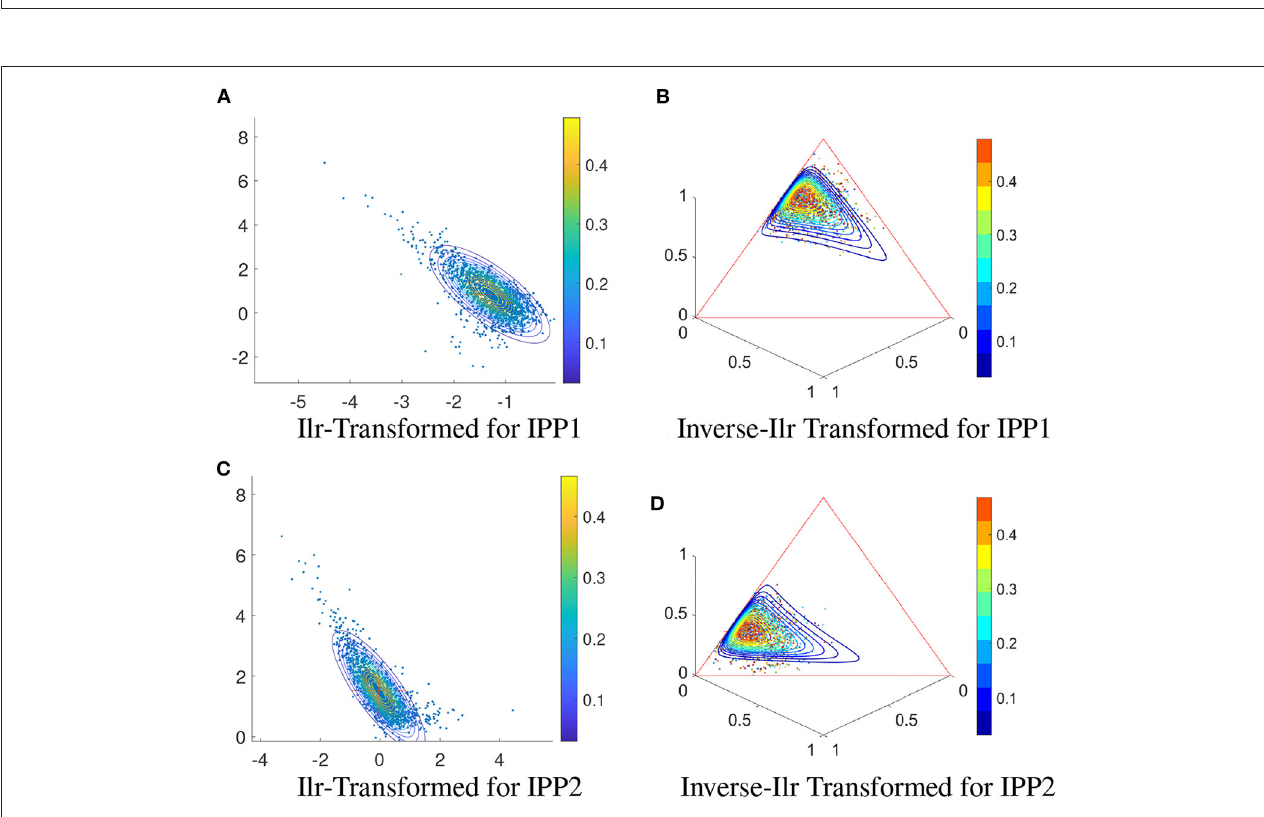
Gaussian contours. The shapes of the contours look different from the single Dirichlet models in Figure 7 , whereas both methods can properly represent single cluster patterns in the given